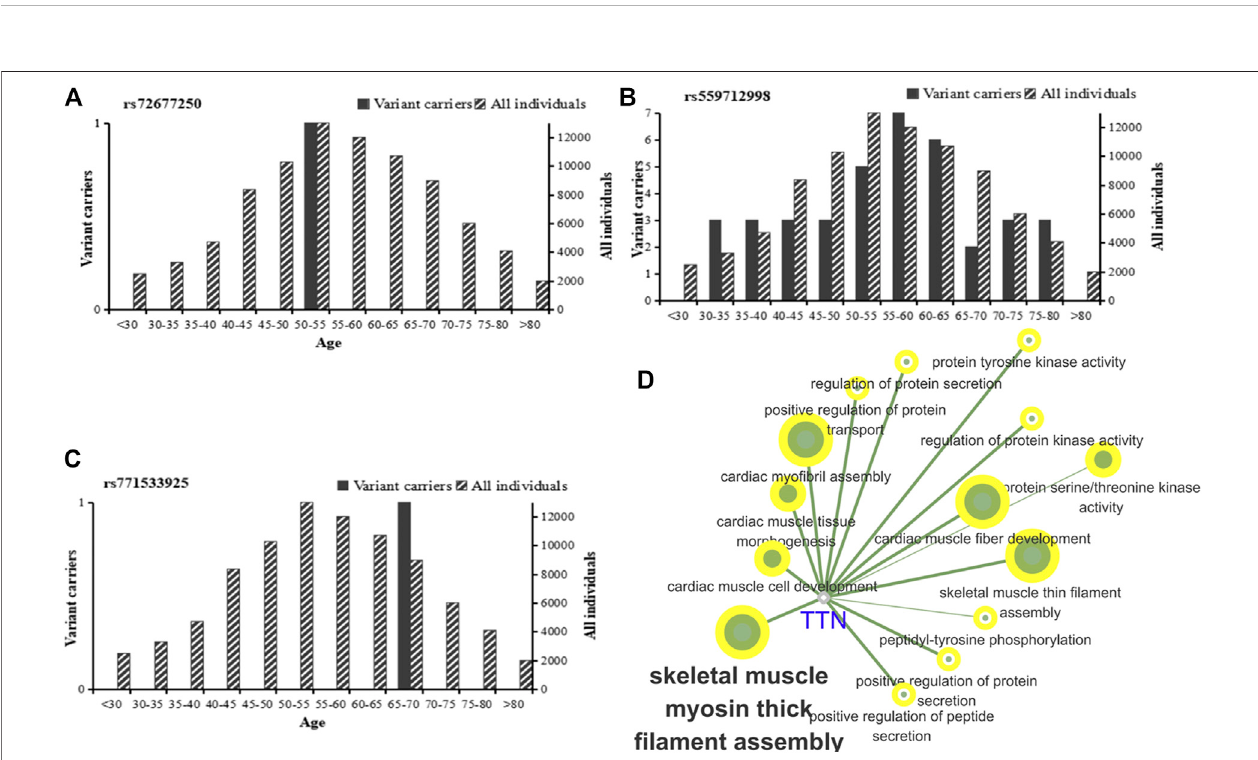
FIGURE 5 | Global population frequency and function analysis of TTN mutation sites. (A – C) Global population frequencies among different age groups for the rs72677250mutation (A) ,rs559712998mutation (B) ,andrs771533925mutation (C) .Analysisincludedheterozygousvariantcarriers,homozygousvariantcarriers. (D) GO functional enrichment analysis of TTN using a two-sided hypergeometric test with Bonferroni correction.